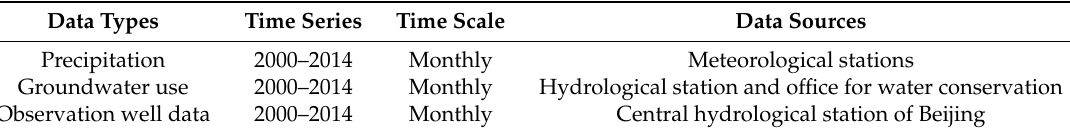
Table 1. List of data sources used in this study.